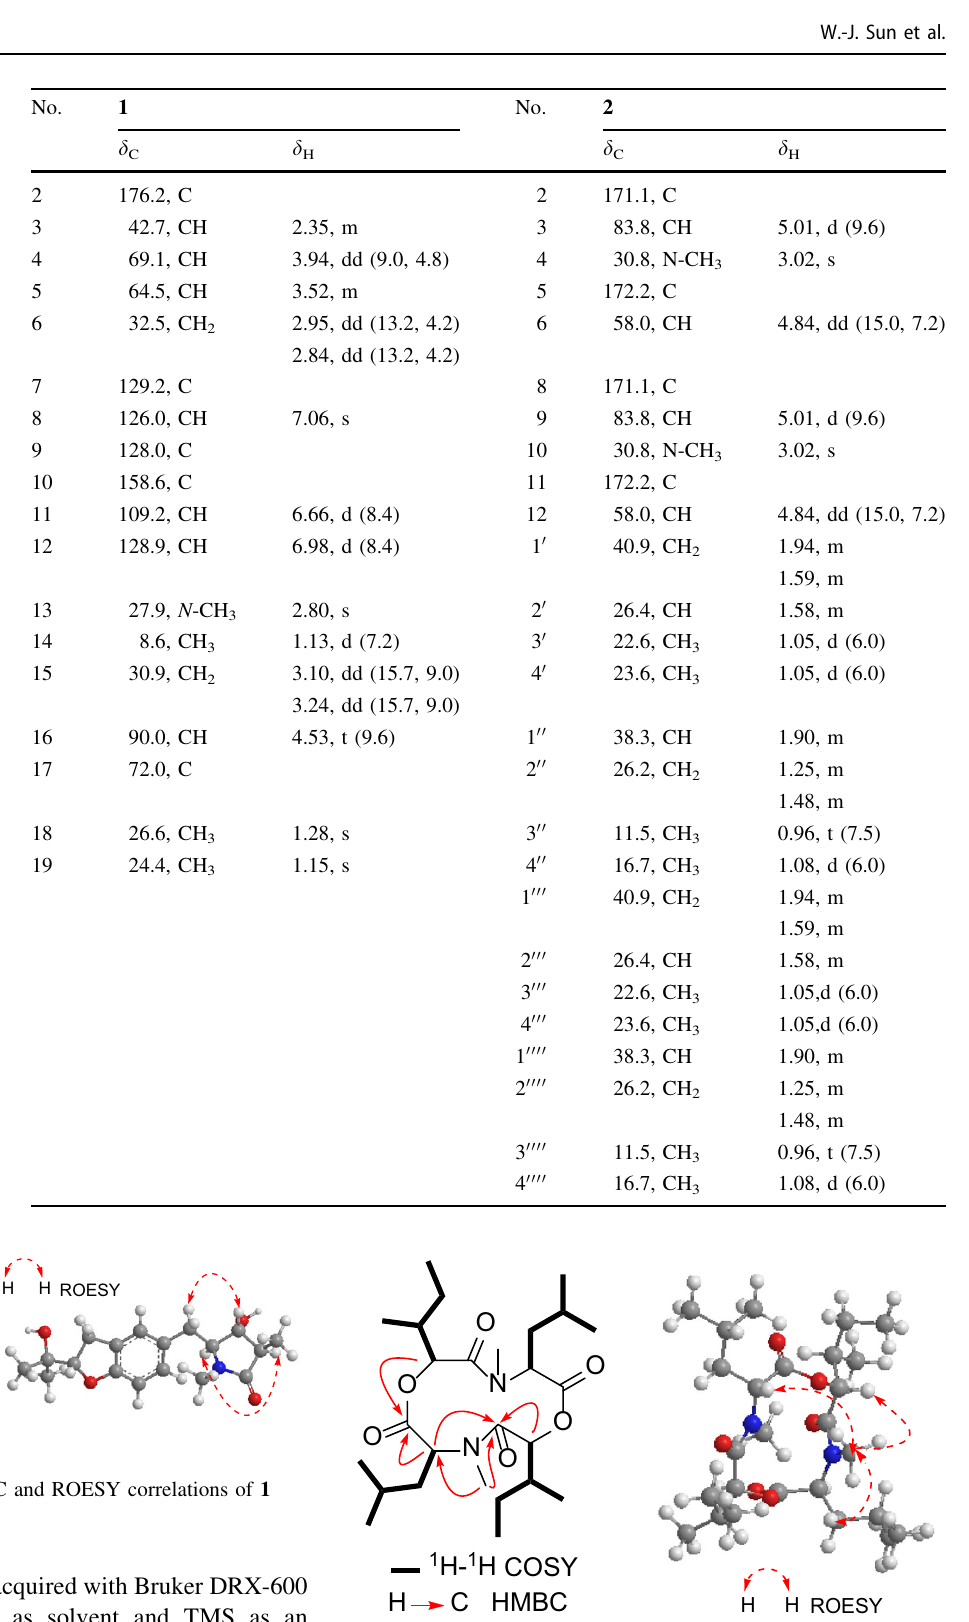
Fig. 3 Key 1 H- 1 H COSY, HMBC and ROESY correlations of